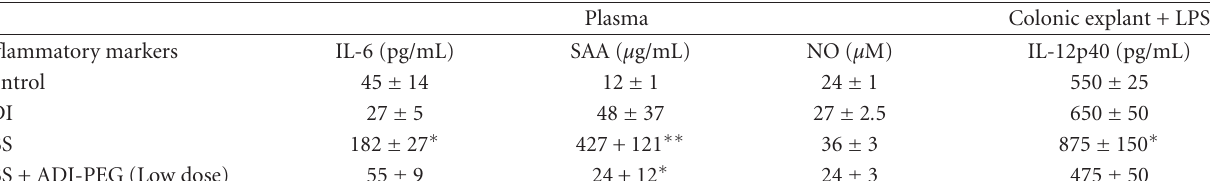
Table 2: WT mice: comparison of inflammatory markers in plasma and colonic explants in BALB/c (WT) mice treated with DSS and ADI-PEG versus sham controls. ∗ P < 0 . 05, ∗∗ P < 0 . 01, and ∗∗∗ P < 0 . 001.